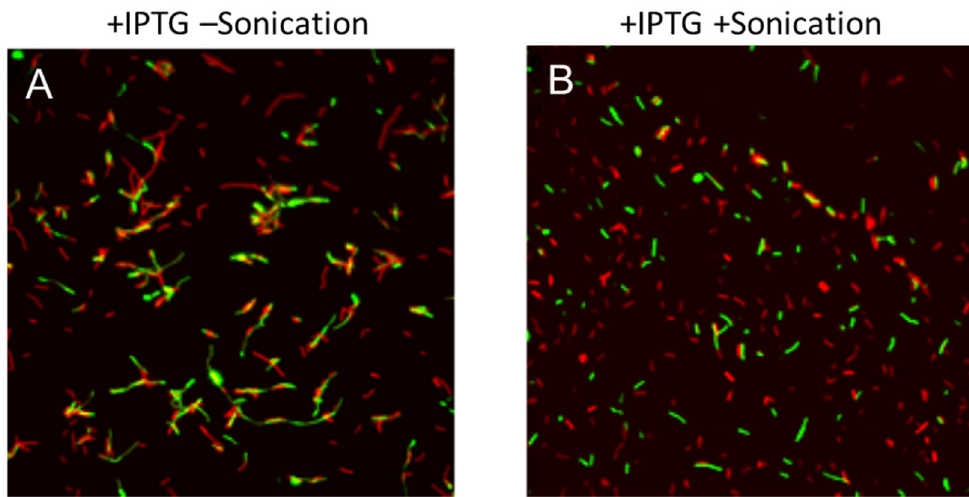
Figure A1. Determination of gate hierarchy. The negative populations V2L ( A ) and V3L ( B ) are de- fined as noise. The experiments were repeated three times with similar results and one set of repre- sentative plots is shown.